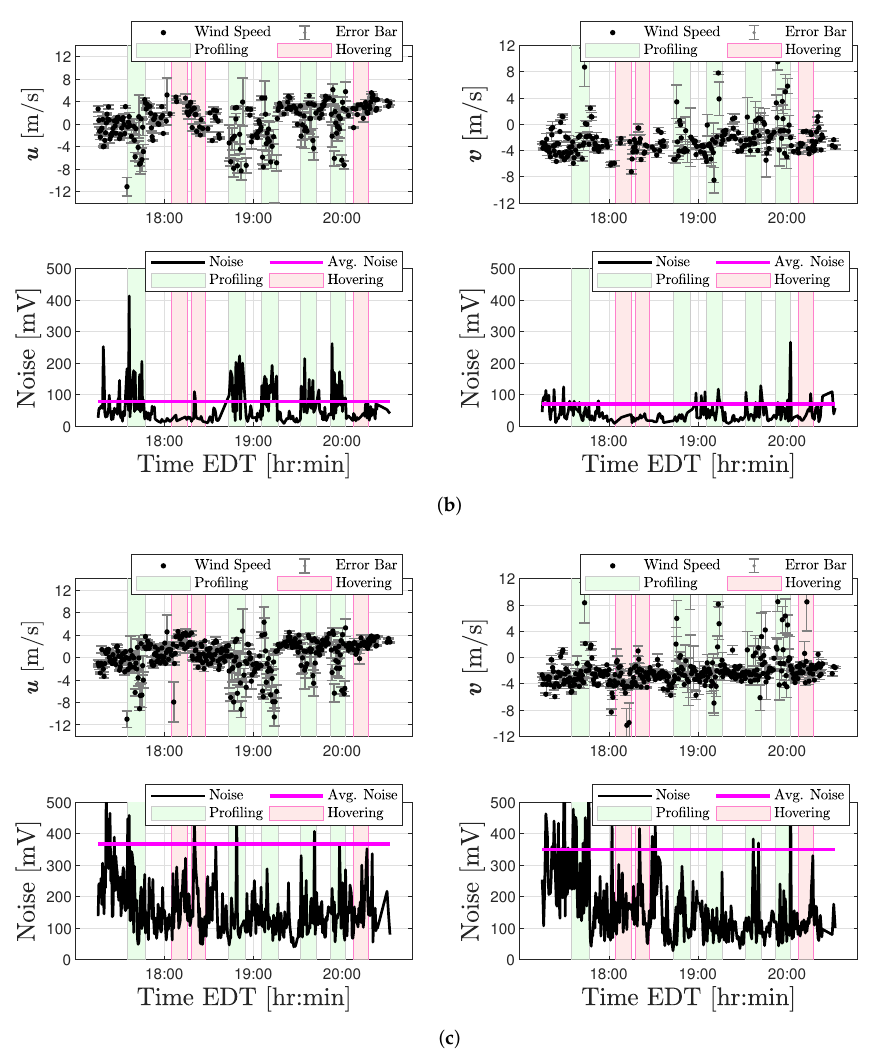
Figure A2. Noise intensity values for u and v wind velocity observations from the LR-SoDAR at ( a ) 110 m AGL, ( b ) 70 m AGL, and ( c ) 30 m AGL.